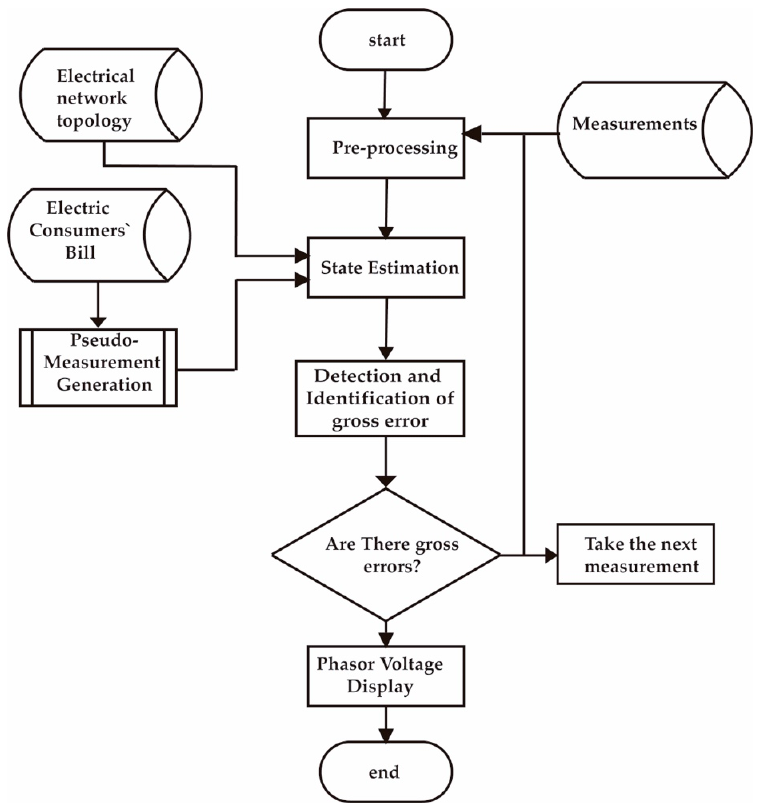
Figure 1. Proposed State Estimation flowchart.